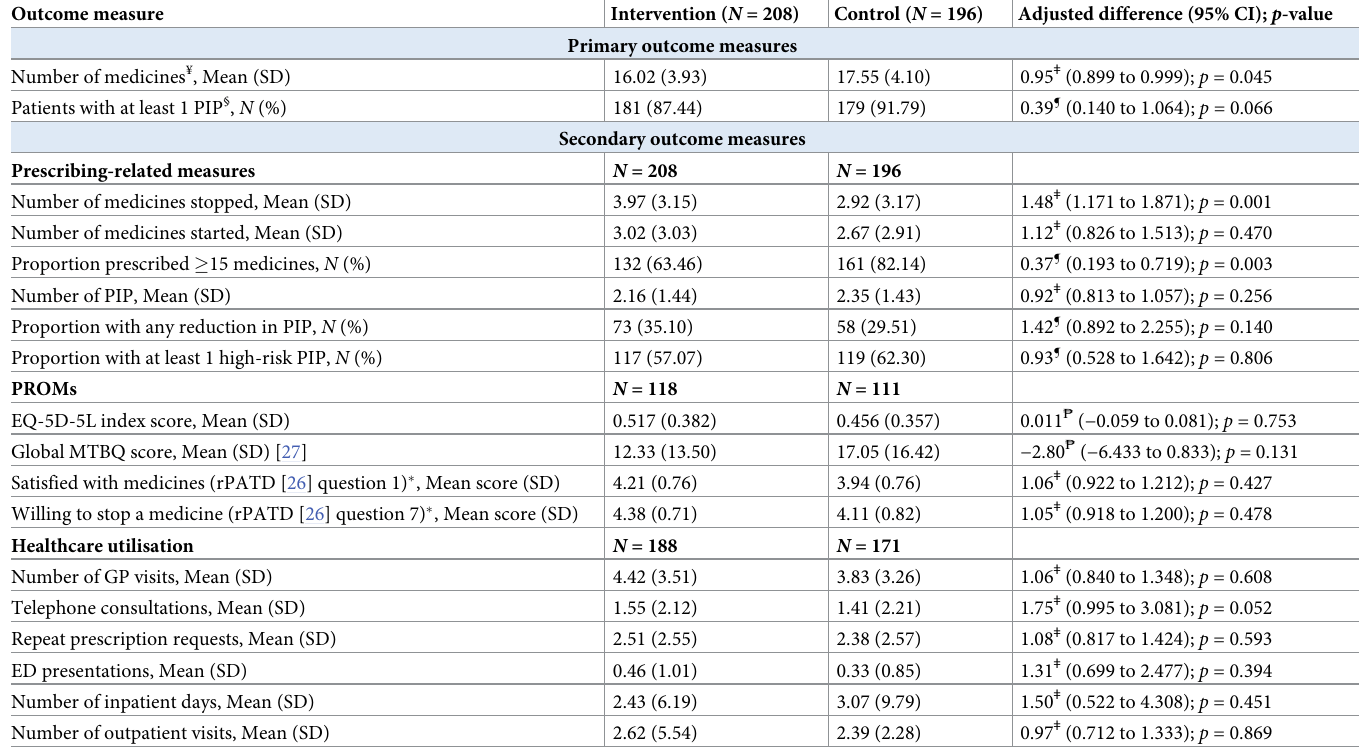
Table 3. Primary and secondary outcome measures at